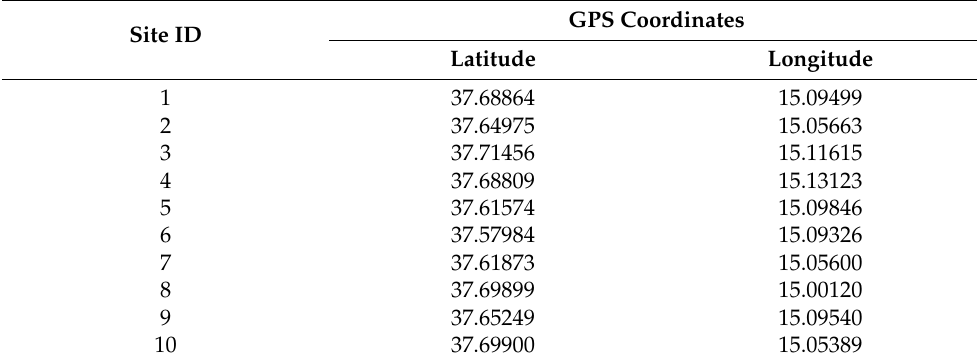
Table 1. The Identification (IDs) and the Global Positioning System (GPS) latitude and longitude coordinates of the investigated pyroclastic products sampling